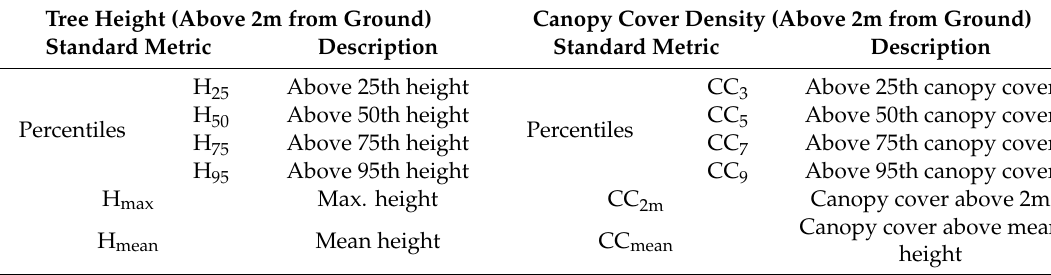
Table 2. Standard tree metrics [16] collected using UAV and ALS. Tree Height (Above 2m from